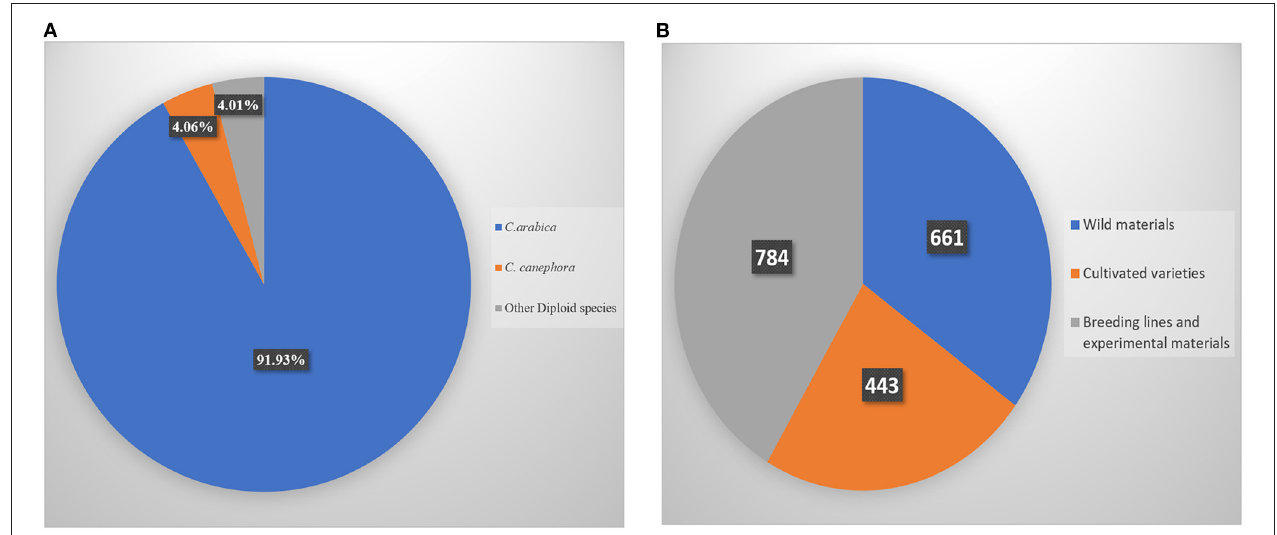
FIGURE 3 | (A) Species composition of CATIE International Coffee Collection; other diploid species include C. sessiliflora , C. pseudozanguebariae , C. brevipes , C. eugenioides , C. racemosa , C, salvatrix , C. congensis , C. spp . (B) Number of accessions of types of coffee genetic resources in CATIE International Coffee Collection. TABLE 4 | Number of accessions in threat categories [Brackets under wild total represent the effective numbers of accessions, after accounting for duplications of ORSTOM accessions (ET codes)]. Threat categories Wild C.